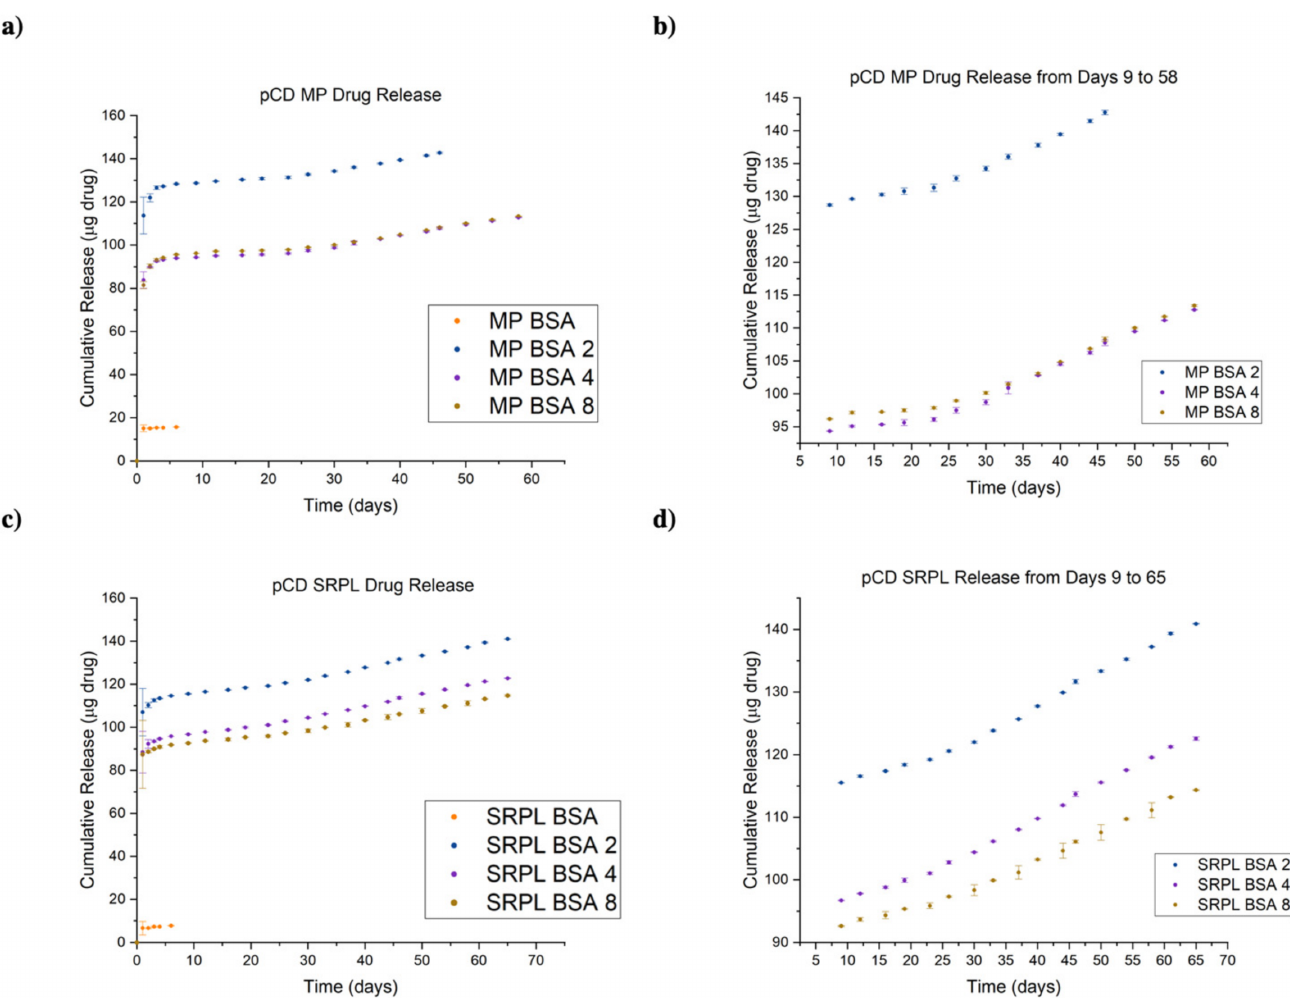
Figure 7. Cumulative drug release curves for BSA–polymer conjugates from ( a ) pCD MPs, ( b ) pCD MPs zoomed in on release days 9–65, and ( c ) pCD SRPL and ( d ) pCD SRPL zoomed in on release days 9–65. All datasets were found to be statistically significant from one another (one-way ANOVA with Tukey, p < 0.05), except BSA 4 and BSA 8 curves in both MP and SRPL